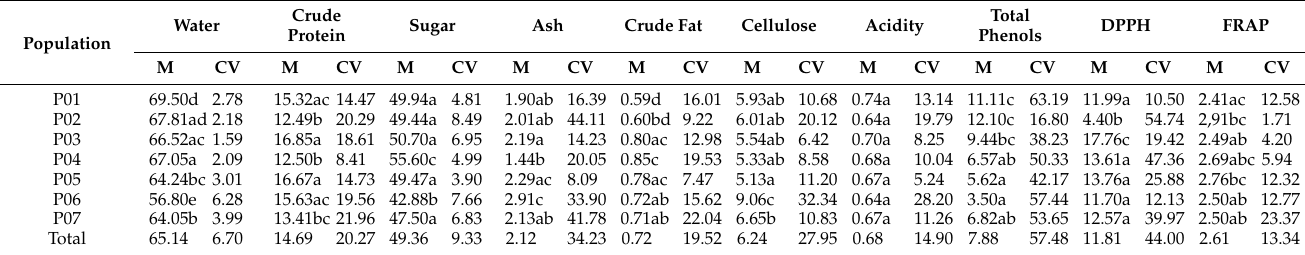
Table 3. Arithmetic means (M) and coefficient of variations (CV/%) for water (g/100 g), crude protein (g/100 g), sugar (g/100 g), ash (g/100 g), crude fat (g/100 g), cellulose (g/100 g), acidity (%), total phenols (mg GAE/g), and antioxidant activity (DPPH %; FRAP mmol Fe 2+ ). All mass fractions were determined on a dry mass basis. Different letters within one column denote statistically significant differences (p < 0.05) by ANOVA and Fisher’s LSD test. Acronyms of populations: P01—Psunj; P02—Tounj; P03—Istria; P04—Novi Vinodolski; P05—Split; P06—Braˇc;